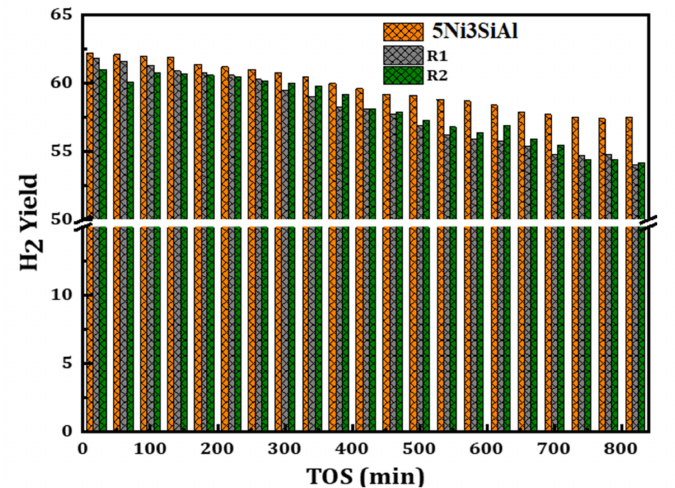
Figure 7. H 2 yield over fresh 5Ni3SiAl catalyst, H 2 yield after first cycle (R1), and H 2 yield after second cycle